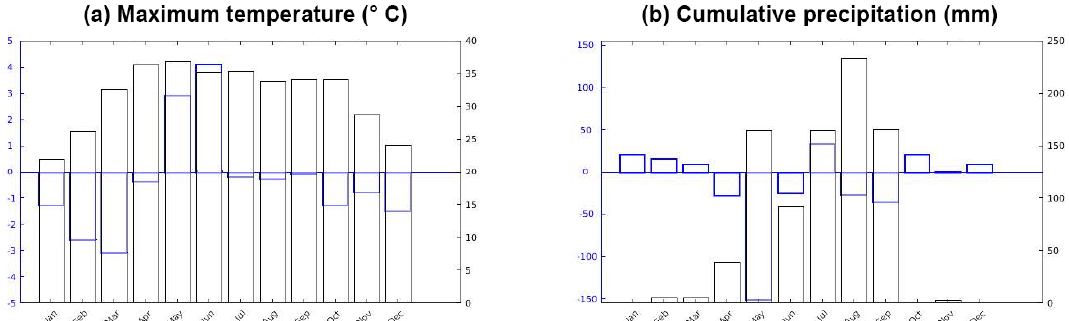
Figure 1. Maximum temperature and cumulative precipitation during the measurement campaign (black) and anomalies (blue) at New Delhi on a monthly basis. Anomalies represent difference between the climatological values and the corresponding values during the measurement campaign. Climatological values were obtained from World Meteorological Organization (http://worldweather.wmo.int/en/city.html?cityId= 224, last access: 11 April 2019) for the site of Safdarjung Airport.